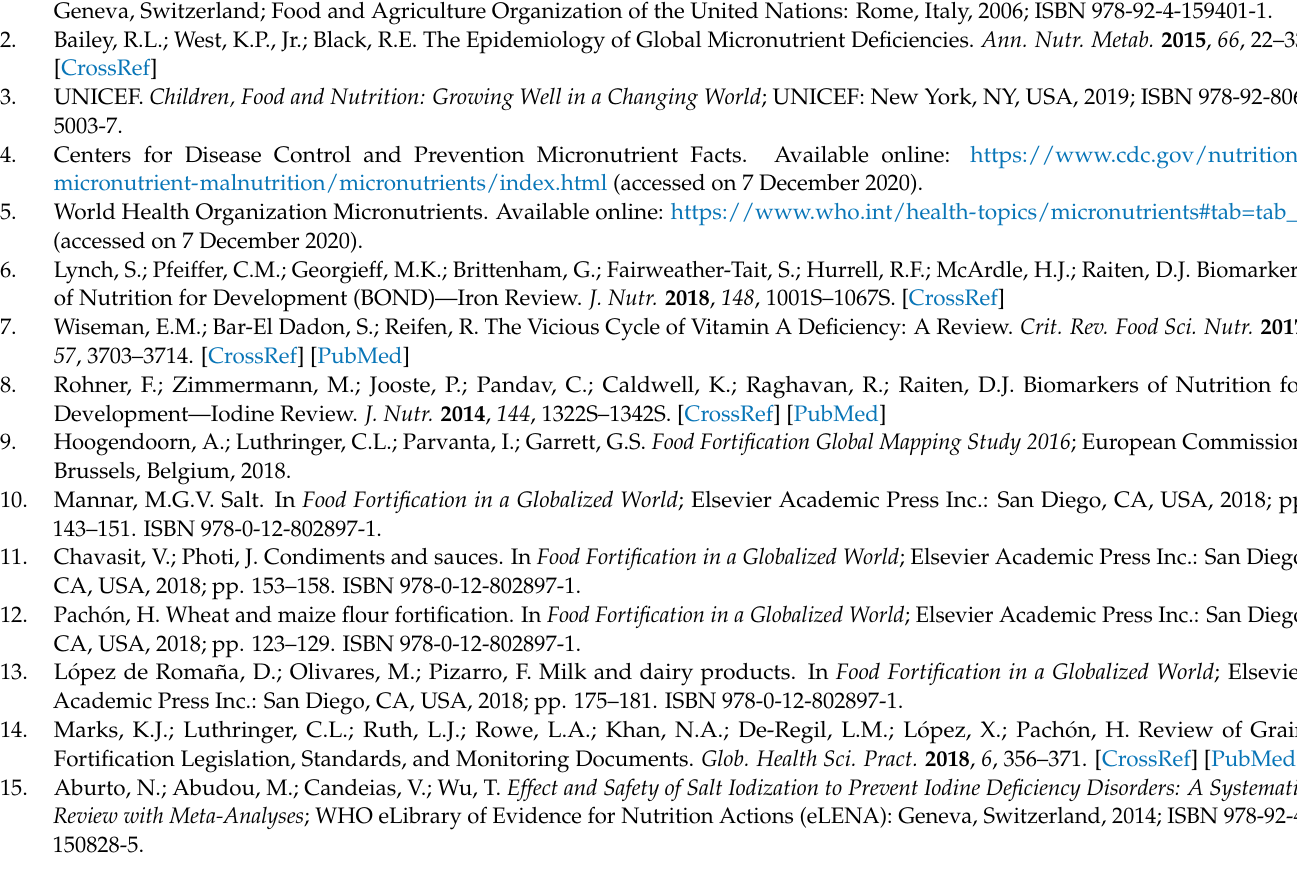
Table S3: The potential nutrient contribution of maize flour, oil, rice, salt, and wheat flour (separately) fortified according to national requirements in the maximum and realistic scenarios, by country, for 153 countries. Table S4: A summary of the potential nutrient contribution of maize flour, oil, rice, salt, and wheat flour (separately) fortified according to national requirements in the maximum and realistic scenarios for 153